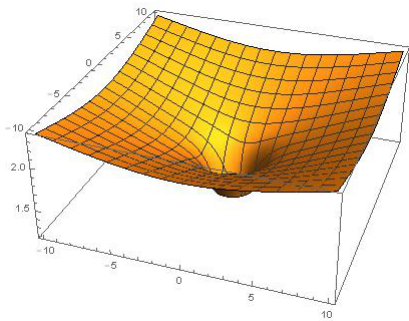
Figure 4. Approximate invariant solution of Equation (56) for − 10 ≤ x ≤ 10, − 10 ≤ y ≤ 10, x 2 + y 2 ≥ 1, k 1 = 4, k 2 = 1, k 3 = 1, ε =